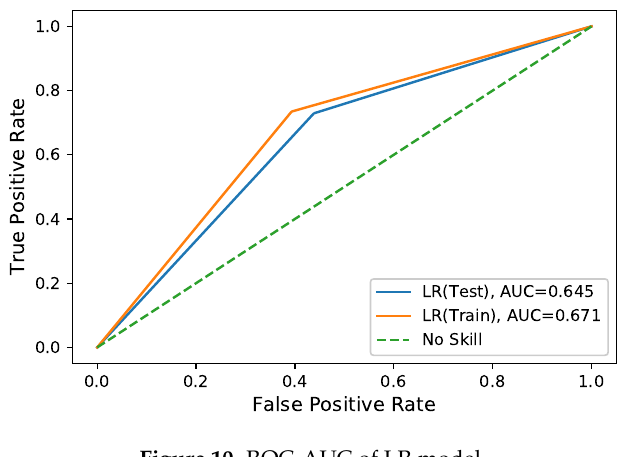
Figure 10. ROC-AUC of LR model. Table 12. Confusion matrix values of LR model.